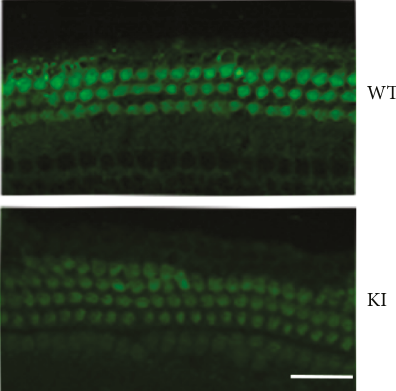
Figure 6: MET activity is not a ff ected in Myo3a mutant mice. FM1- 43 staining showed that the MET activity is normal in Myo3a mutant mice. Scale bar =20 μ m.